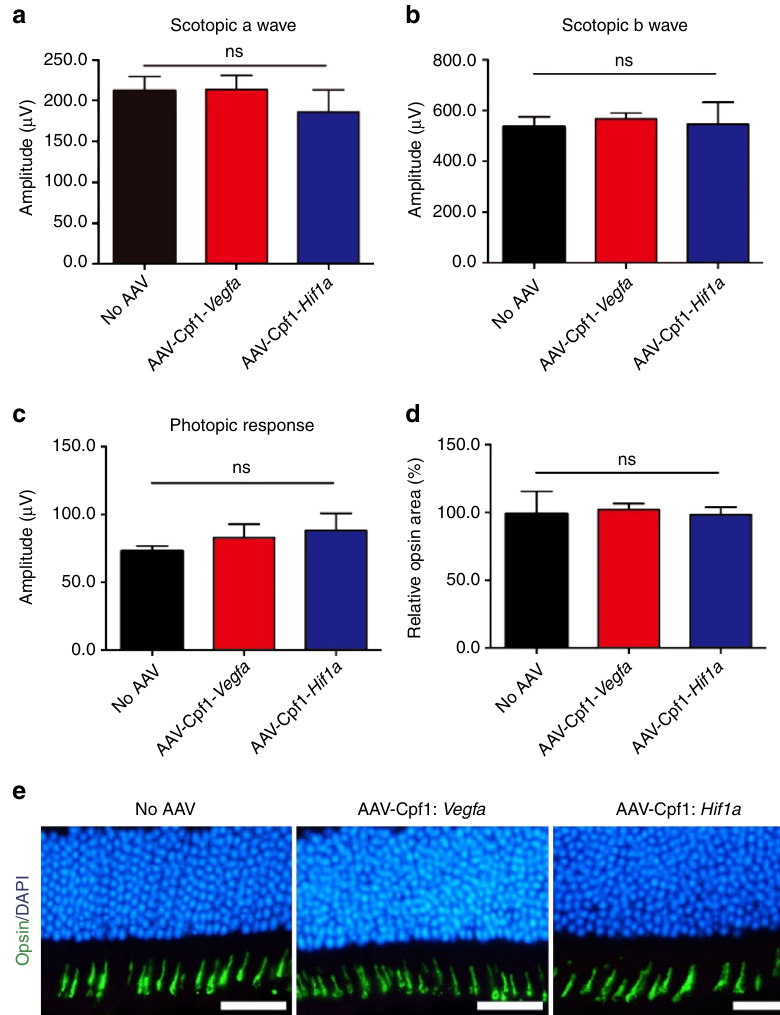
Fig. 4 LbCpf1 targeted to Vegfa or Hif1a does not affect cone function. a – c At day 42 post-AAV injection, full- fi eld ERG was performed to evaluate retinal function. There was no signi fi cant decrease in the a scotopic a wave, b scotopic b wave, or c photopic response in mice treated with AAV-Cpf1- Vegfa or - Hif1a compared to normal control mice. Error bars indicate s.e.m. ( n = 4). One-way ANOVA. ns, not signi fi cant. d , e Opsin-positive areas in the retina at day 42 post-injection. d Relative opsin-positive areas of the AAV-Cpf1-injected mice were normalized to that of the AAV-uninjected negative control mice. Error bars indicate s.e.m. ( n = 4). Student ’ s t- test. ns not signi fi cant. e Representative images of opsin positive areas in mice treated with AAV-Cpf1-